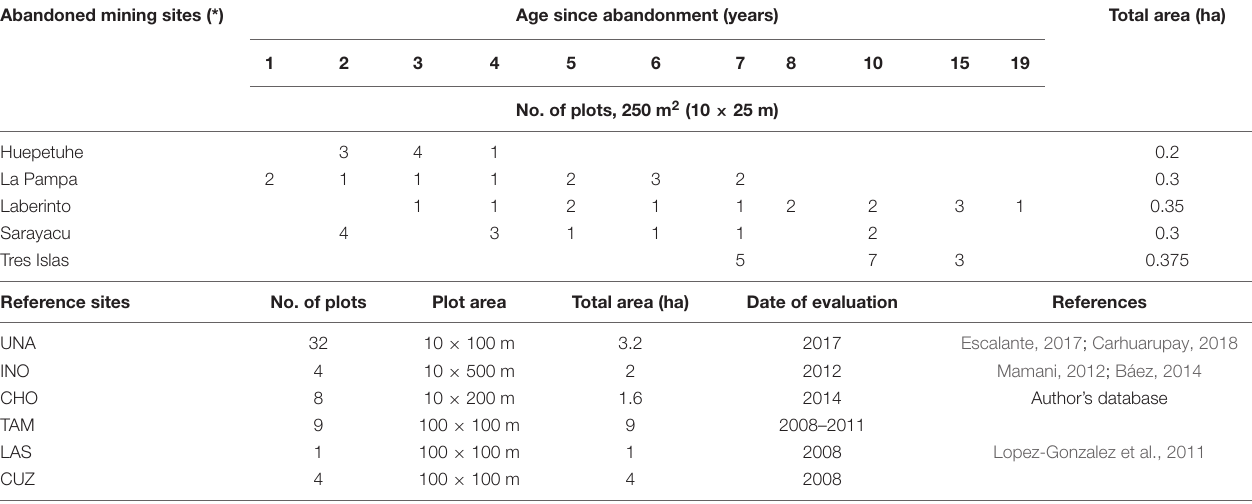
TABLE 1 | Plot characteristics in abandoned mining and reference sites. Abandoned mining sites